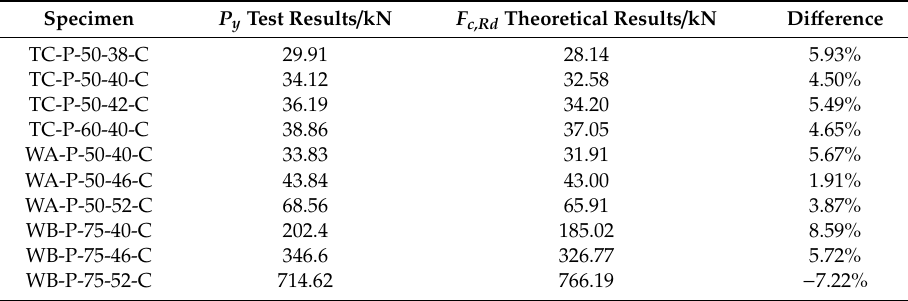
Table 2. Comparison of compressive bearing capacity.